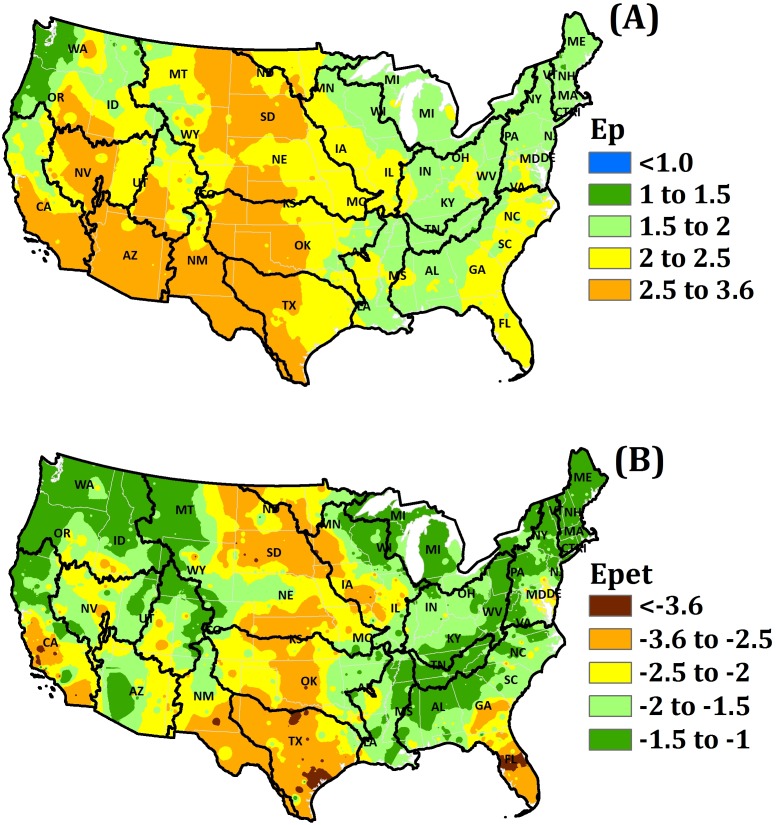
Hydro-climatology of the conterminous US; (A) Precipitation elasticity of streamflow (εp) and (B) Evapotranspiration elasticity of streamflow (εpet).